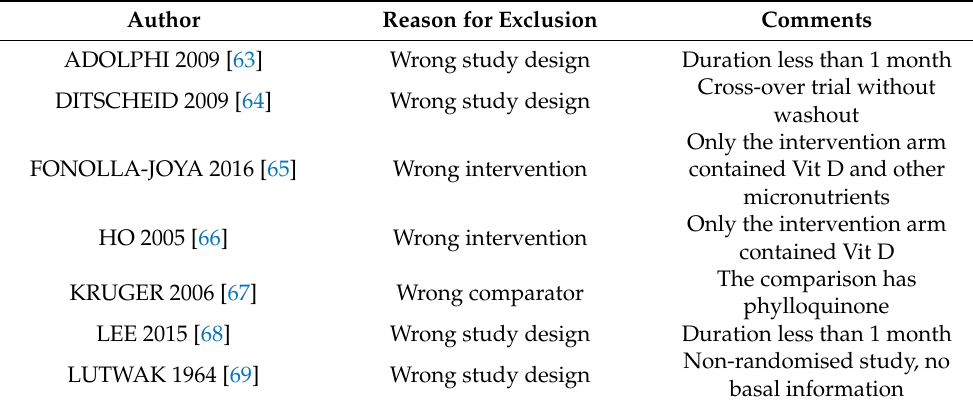
Table A2. Reasons for